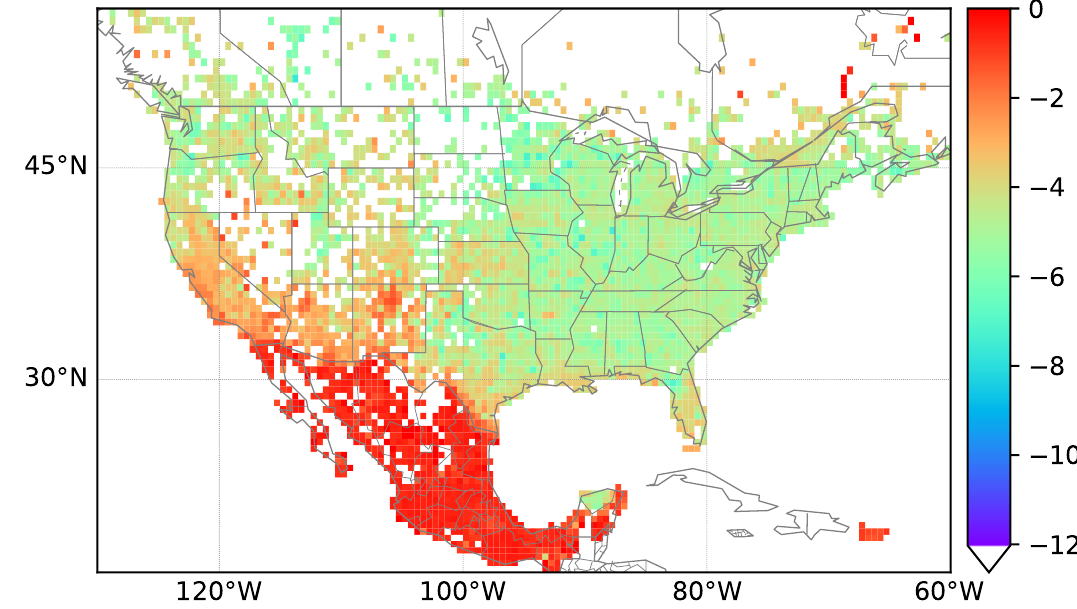
Figure 4. Heatmap of North America showing the density of streets classified as Spanish. Colors indicate the density of streets in this area, thus the logarithmic value of the number of streets normalized by all streets in the cell of the